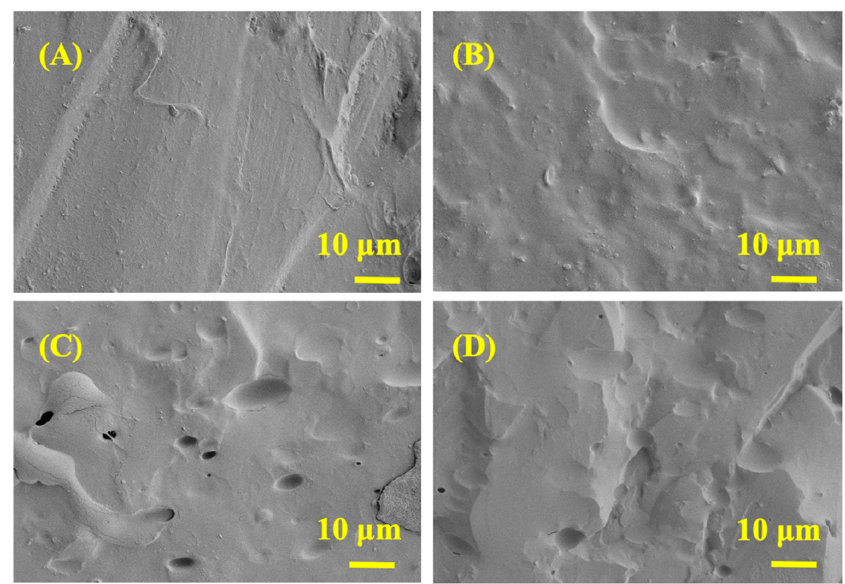
Figure 2. SEM and element-mapping images of PVA and MXene/PVA nanocomposites after brittle fracture: ( A ) PVA; ( B ) MXene 1 . 0% /PVA; ( C ) PVA-PVPA 10% -PEPA 5% ; and ( D ) MXene 1 . 0% /PVA- PVPA 10% -PEPA 5% .